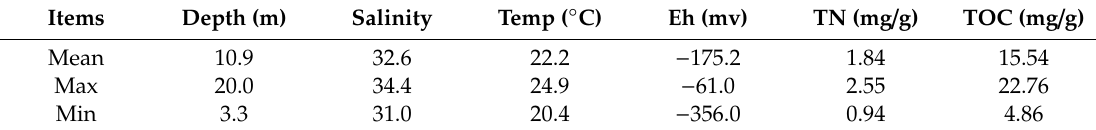
Table 2. Physiochemical properties of surfaces sediments of Daya Bay.